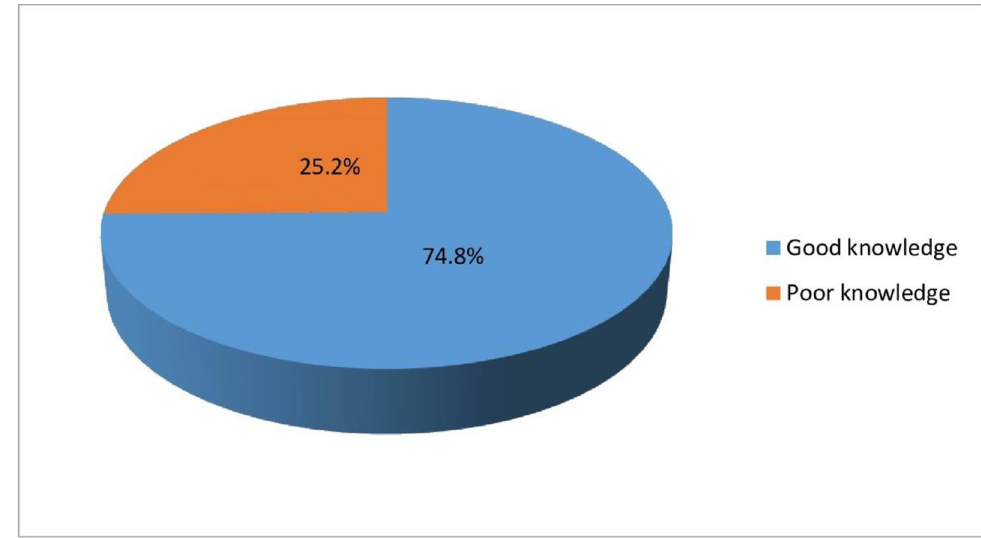
Fig 1. Overall knowledge of maternal mortality and its major causes among respondents. Amongst the nurses and midwives, 58 (25.2%) had poor knowledge of maternal mortality and its major causes and 172 (74.8%) of them had good knowledge (Fig